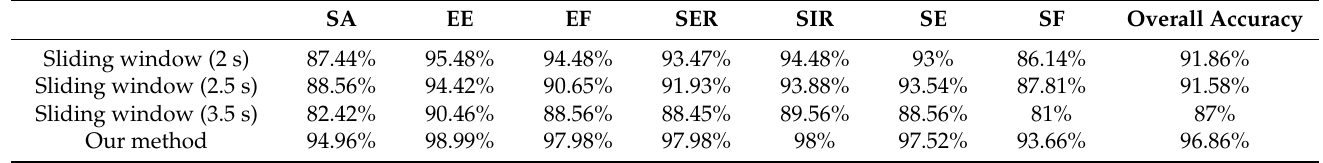
Table 7. Performance comparison of different segmentation techniques using F1 score and overall